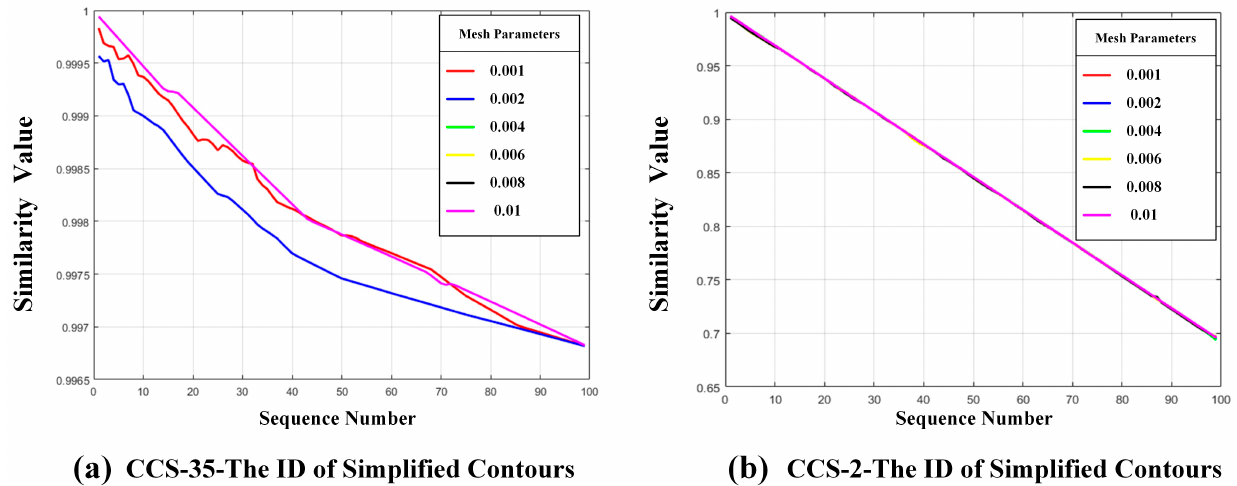
Figure 14. Similarity between the simplified and initial contours with different mesh parameters. ( a ) CCS-35. ( b ) CCS-2.